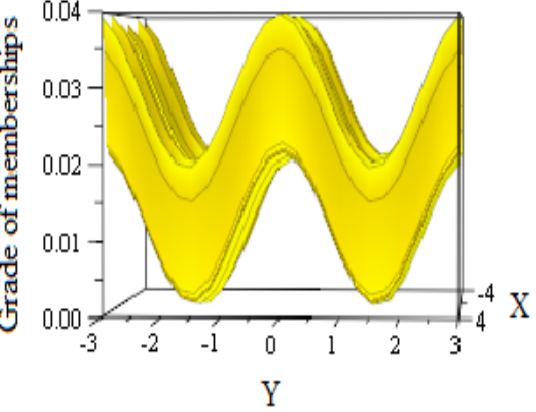
Figure 1. Graphical representation of Fs -valued map in Example 2.